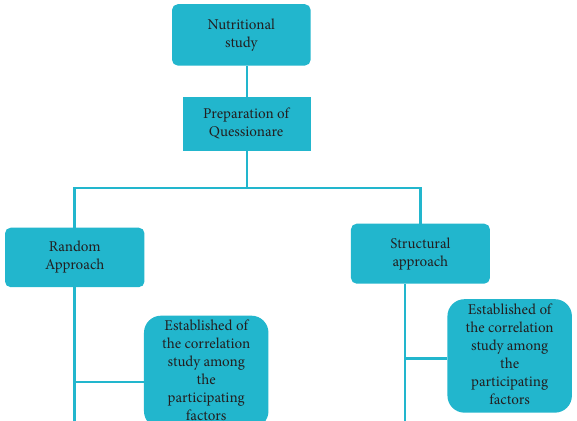
Figure 1: Proposed nutrition’s impact determination